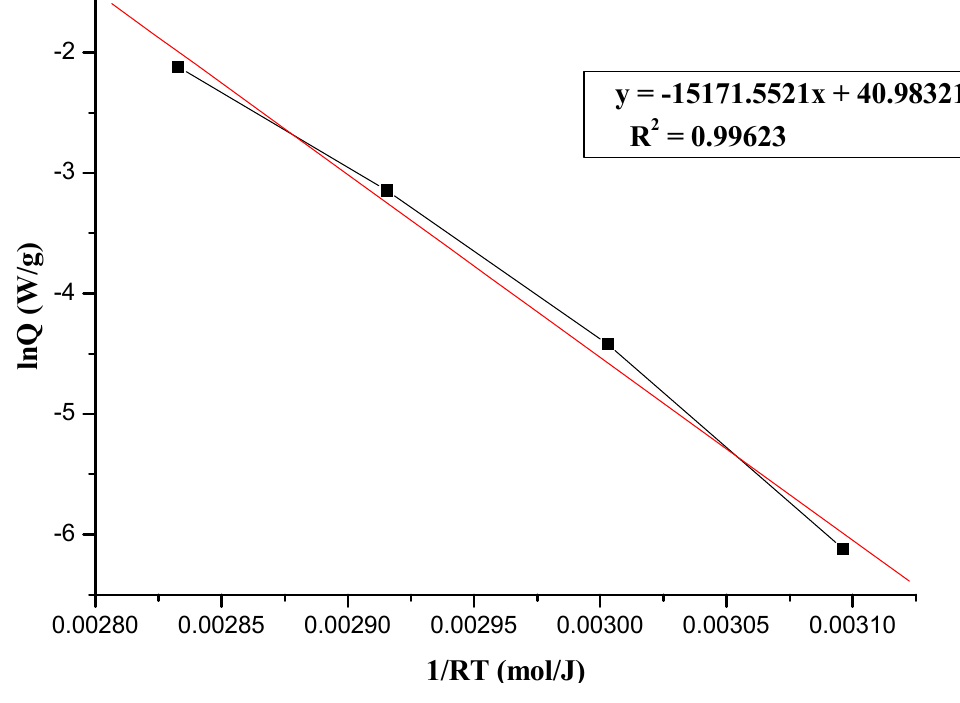
Figure 4. Determination of activation energy from the slope of lnQ vs. 1/(RT) for the thermal decomposition of 95 mass% LPO with 6 N HNO TAM III